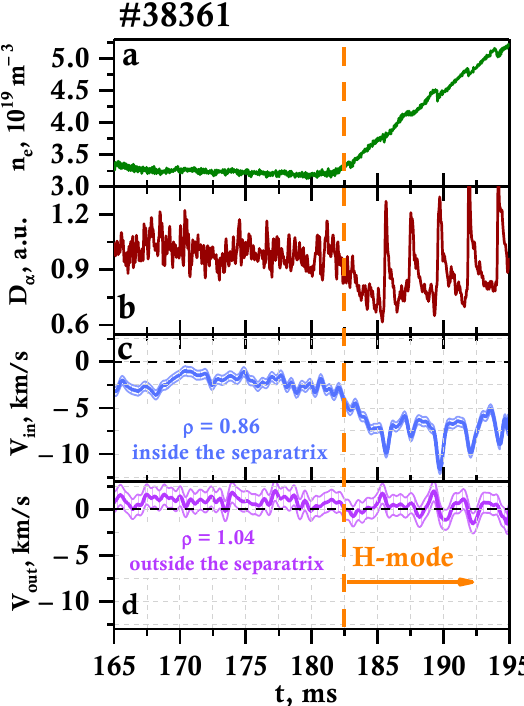
Figure 4. Temporal evolution of different plasma parameters on Globus-M2 during the LH transition: ( a ) electron density n e , ( b ) D α signal, ( c ) plasma rotation velocity at ρ = 0.86, and ( d ) plasma rotation velocity at ρ = 1.04.